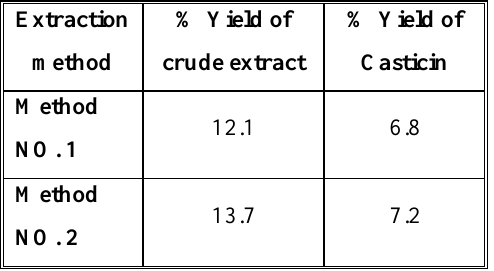
Table 1: Percentages of crude extracts and Casticin obtained from the fruits of Vitex. agnus –castus.